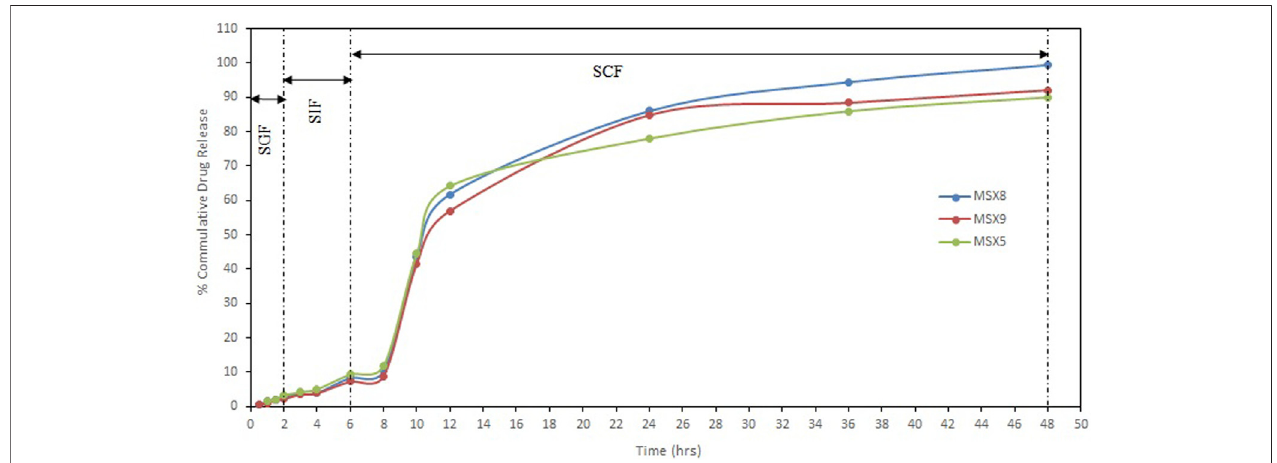
FIGURE7| In-vitro releasepro fi leofmethotrexatefromeudragitS100nanoparticlesindifferentsimulatedGItract fl uids(SGF,simulatedgastric fl uid;SIF,simulated intestinal fl uid; SCF, simulated colonic fl uid).